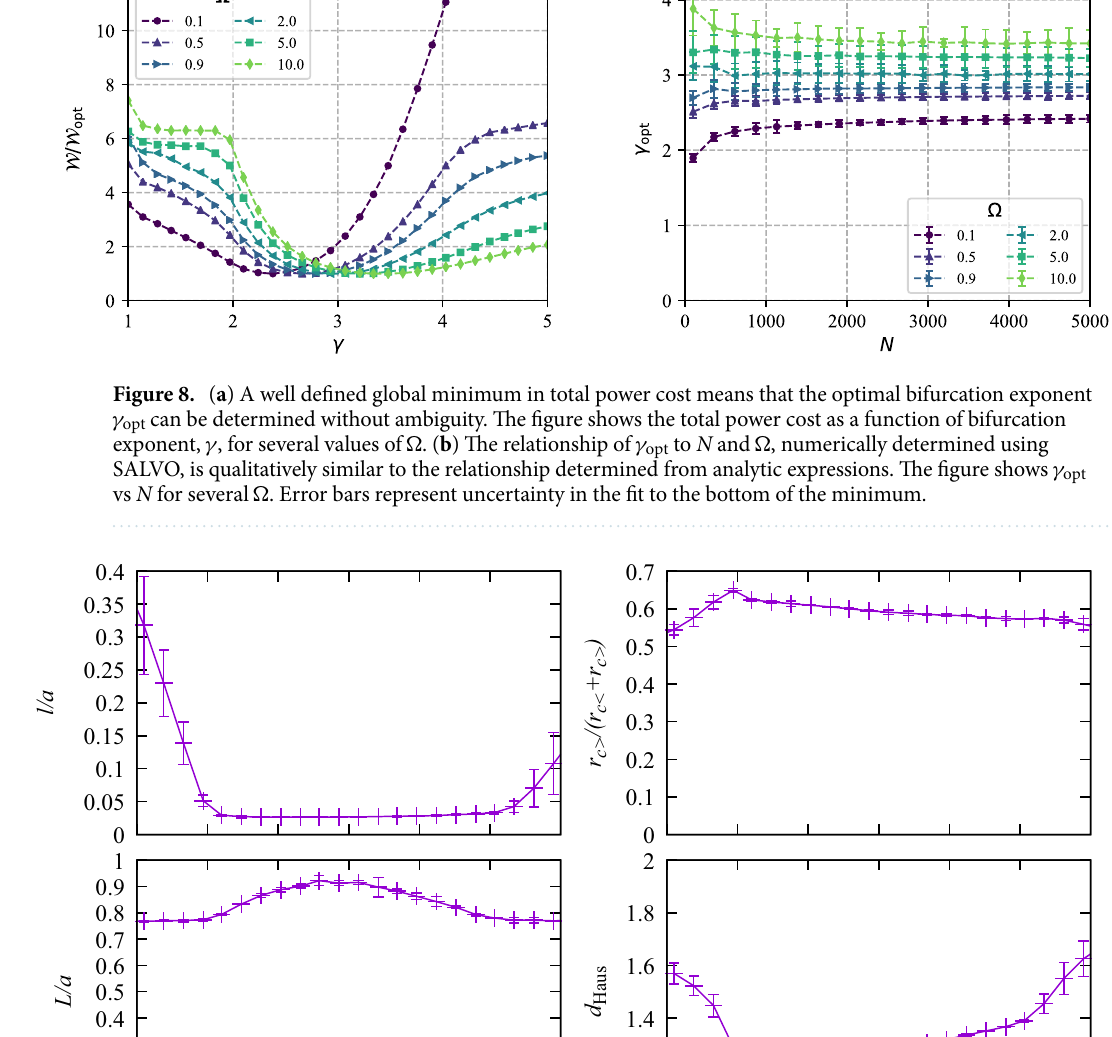
Figure 9. Sensitivity of morphological properties to uncertainty in (cid:31) , for (cid:31) show little sensitivity in the physiological range 2 < γ < 4